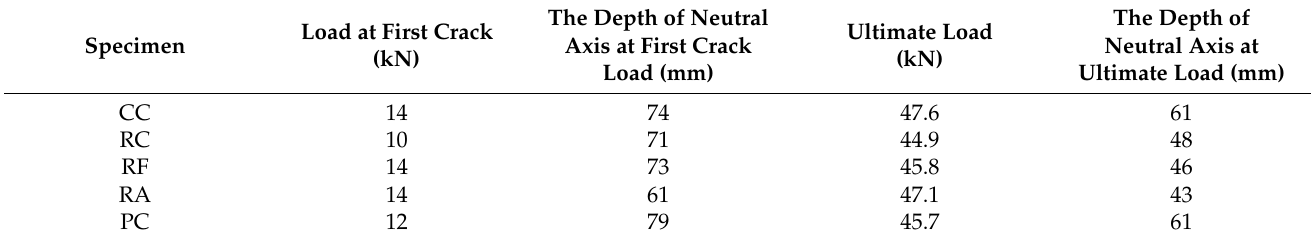
Table 8. Depth of neutral axis in first crack load and failure load.